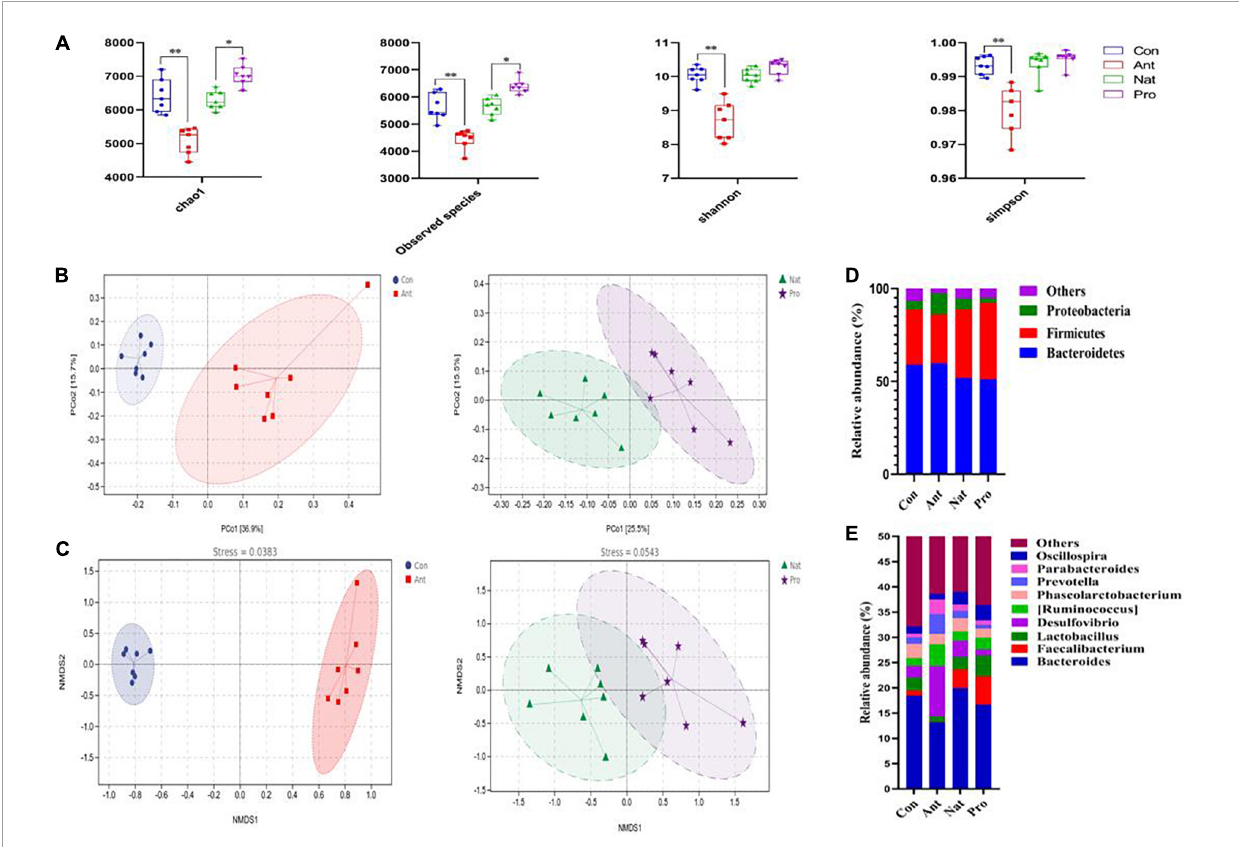
FIGURE2 Effects of dietary probiotic supplementation on the gut microbial diversity of antibiotic-treated hens. (A) Analysis of the alpha diversity of the gut microbiota by Chao-1, Observed species, and Shannon and Simpson indexes. Differences are assessed by the Mann–Whitney U test with significance defined as ∗ P < 0.05, ∗∗ P < 0.01. (B) Principal coordinates analysis (PCoA) plots were generated using OTU metrics based on the weighted UniFrac distance similarity for the samples in different groups highlighted with different colors. (C) Non-metric multidimensional scaling (NMDS) at the genus level. Points of different colors or shapes represent samples in different treatment groups. (D) Graph showing the mean percentage of the main phylum level of the cecal microbiota ( n = 7). (E) Graph showing the mean percentage of the main genus level of the cecal microbiota ( n =